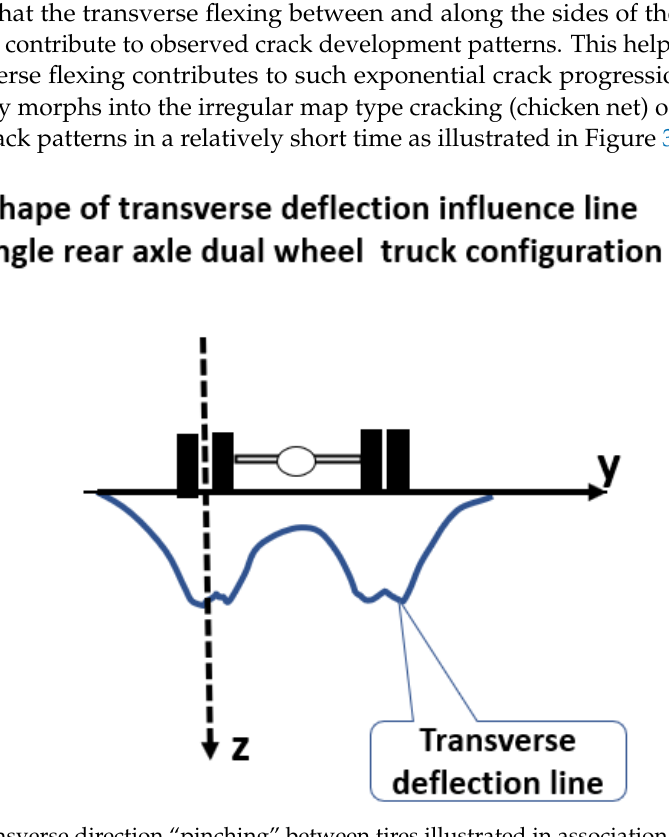
Figure 9. Transverse direction “pinching” between t ires illustrated in association with longitudinal deflection (Partial redrawn from original Dehlen deflection (Partial redrawn from original Dehlen 1962).